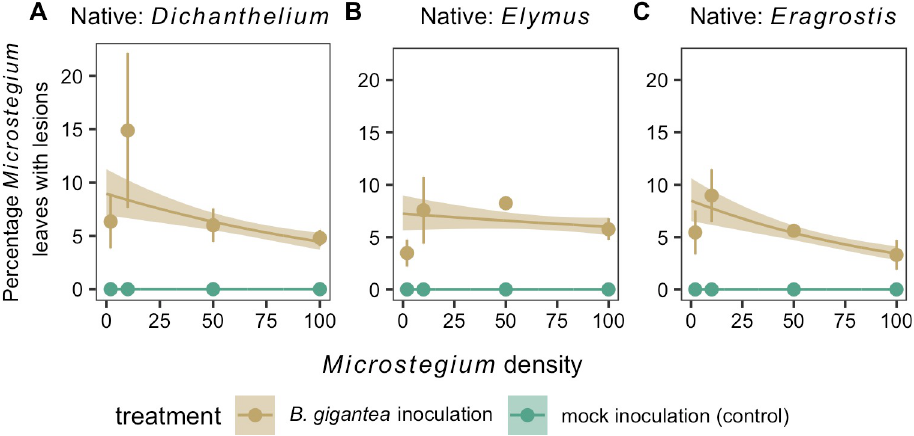
Fig 2. Microstegium disease incidence. The percentage of Microstegium leaves per pot with lesions following B . gigantea or mock inoculation across the Microstegium density gradient in the presence of (A) Dichanthelium , (B) Elymus , and (C) Eragrostis . Observations (points and error bars, mean ± 95% confidence intervals) and model fits (lines and shaded ribbons, mean ± 95% credible intervals) are